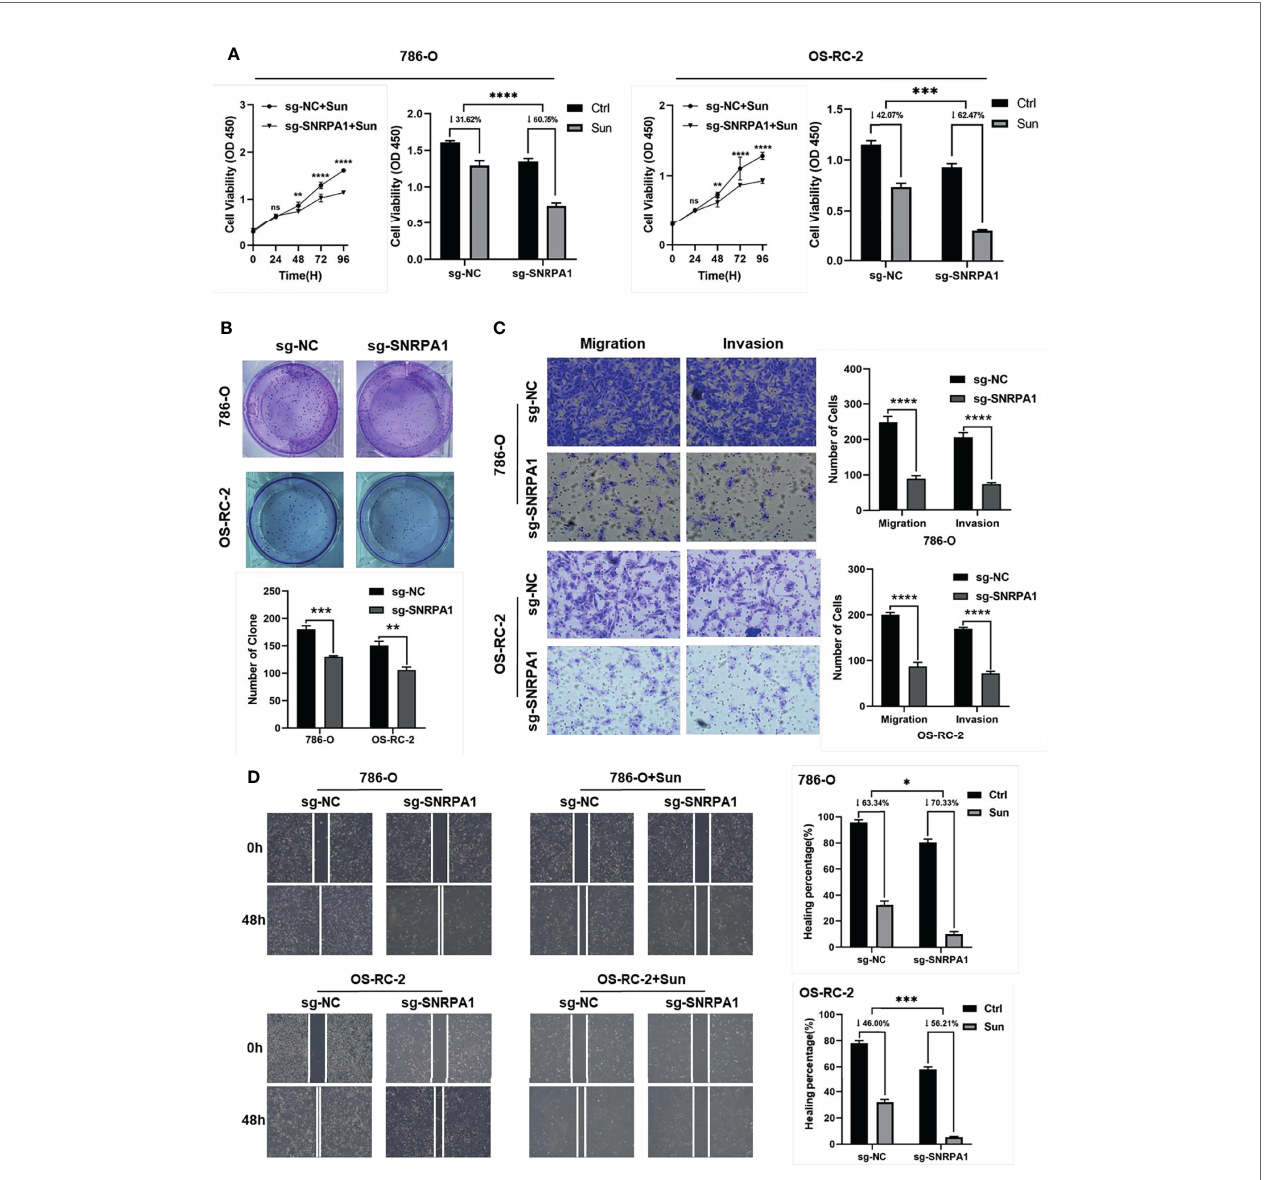
FIGURE 6 | Validation the function of SNRPA1 with in vitro experiments by 786-O and OS-RC-2 cell lines. (A) Cell proliferation of 786-O and OS-RC-2 (right: treated with sunitinib) after being transfected with NC and SNRPA1 cas9-sgRNA plasmid, ***p < 0.001. (B) Clone formation ability of 786-O and OS-RC-2 after being transfected with NC and SNRPA1 cas9-sgRNA plasmid, ***p < 0.001. (C) Wound healing of 786-O and OS-RC-2 (right: treated with sunitinib) after being transfected with NC and SNRPA1 cas9-sgRNA plasmid, ***p < 0.001. (D) Cell migration and migration of 786-O and OS-RC-2 after being treated with NC and SNRPA1 cas9-sgRNA plasmid, ***p < 0.001, scale bar = 200 m m. *p < 0.05, ****p value is too small and is close to